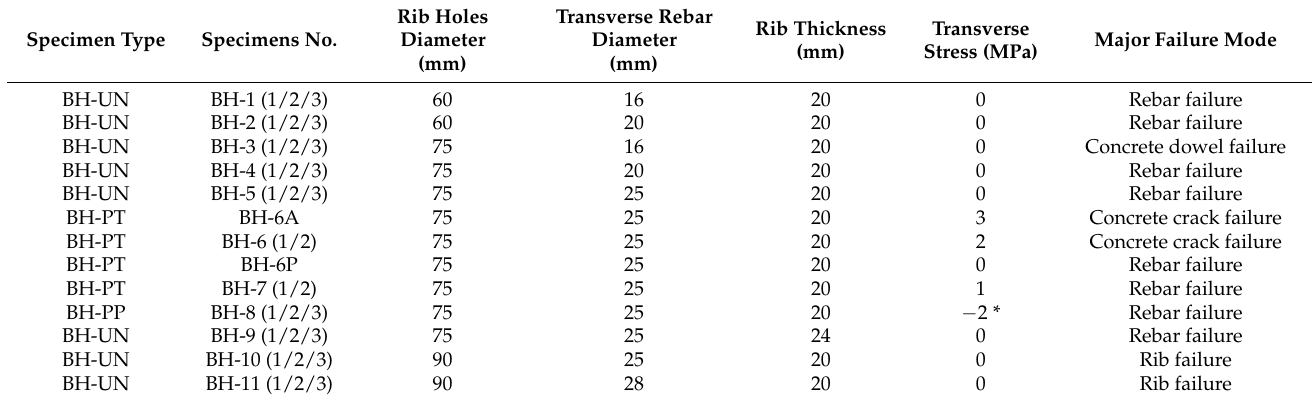
*: minus sign represents compressive forces.